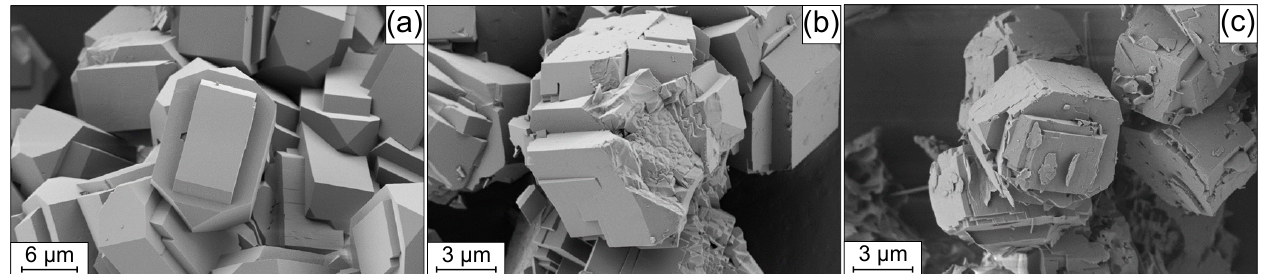
Figure 1. SEM images of the as synthesized ( a ) B-, ( b ) Ga- and ( c ) Ti-silicalite samples. The MFI type of framework structure of all samples is confirmed by XRD [32].